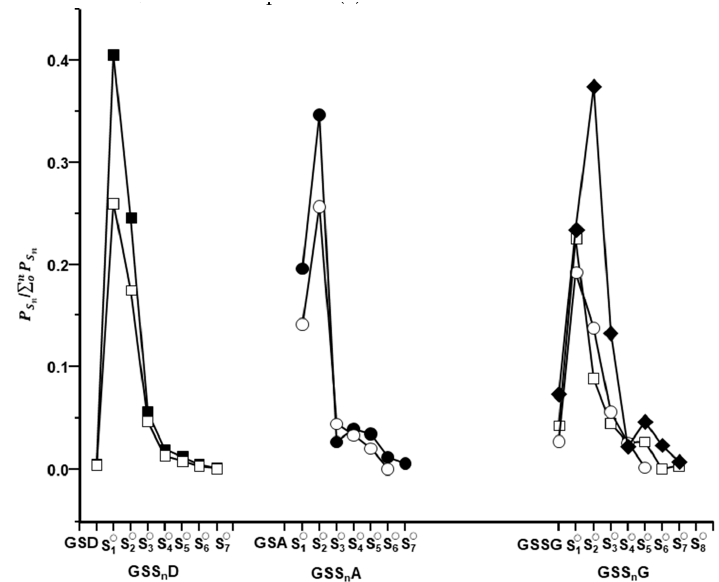
Figure 10. Relative distributions of DH trapped GSS n D, acetamide trapped GSS n A, and oxidized GSS n G species determined from LCMS study of reaction of GSNO (1 mM) with Na 2 S (1 mM) and radical clock vinylcyclopropane (5 mM) in iP buffer at pH 7; (filled squares) in the presence of DH (5 mM), (filled circles) in the presence of IA (5 mM); (open squares) in the presence of DH and vinylcyclopropane, (open circles) in the presence of IA and vinylcyclopropane, and (filled diamond) in the presence of only vinylcyclopropane.